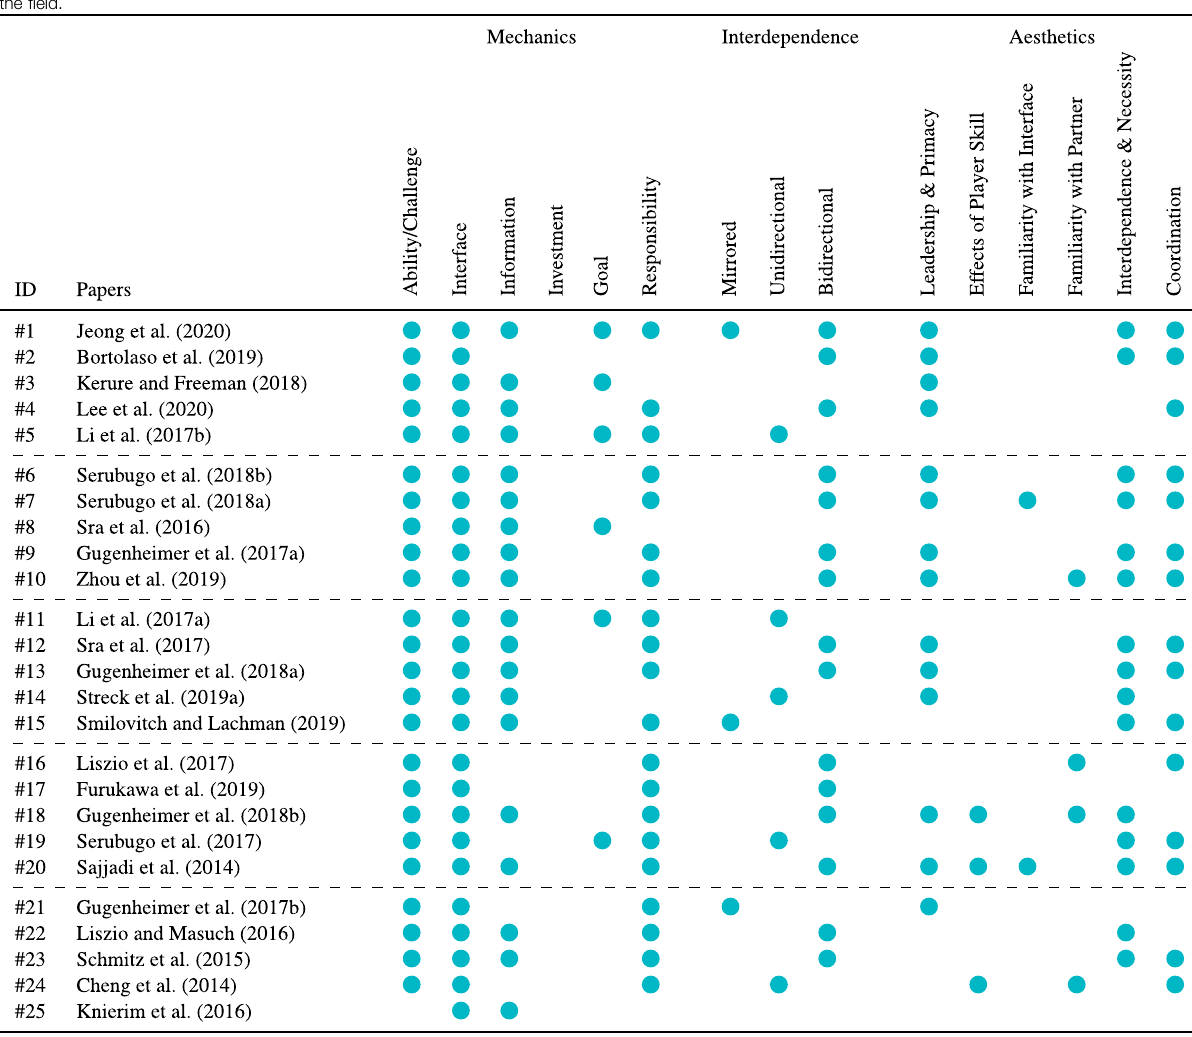
Frontiers in Virtual Reality |